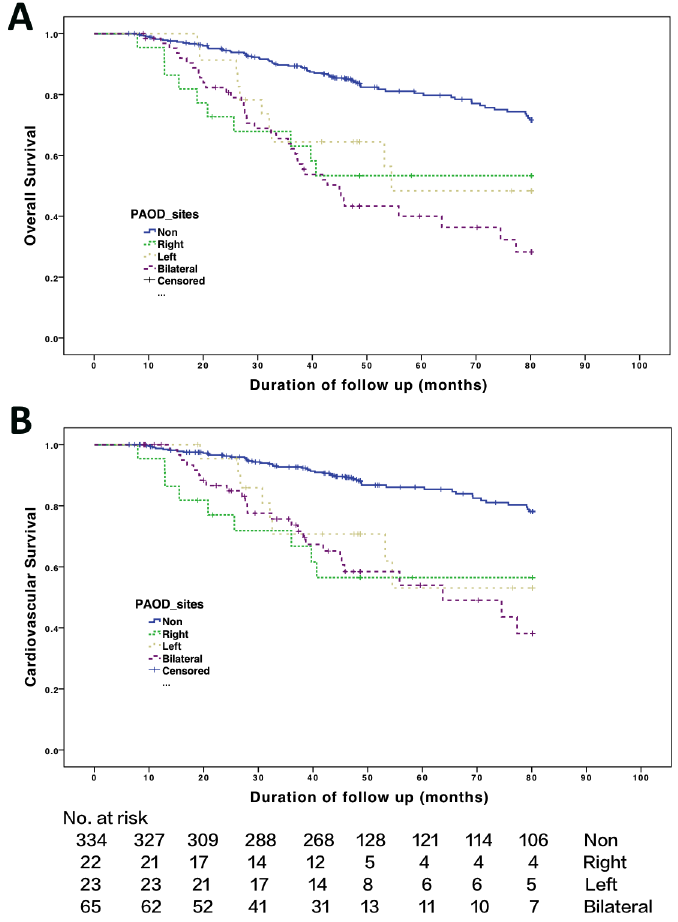
Fig 1. Kaplan — Meier survival curves. Probabilities of (A) overall survival with log-rank test: χ 2 = 60.89; P (cid:3) 0.001 in the four groups and χ 2 = 2.02; P = 0.364 in the three PAOD groups. (B) Cardiovascular survival with log-rank test: χ 2 = 45.24; P (cid:3) 0.001 in the four groups and χ 2 = 0.69; P = 0.708 in the three PAOD